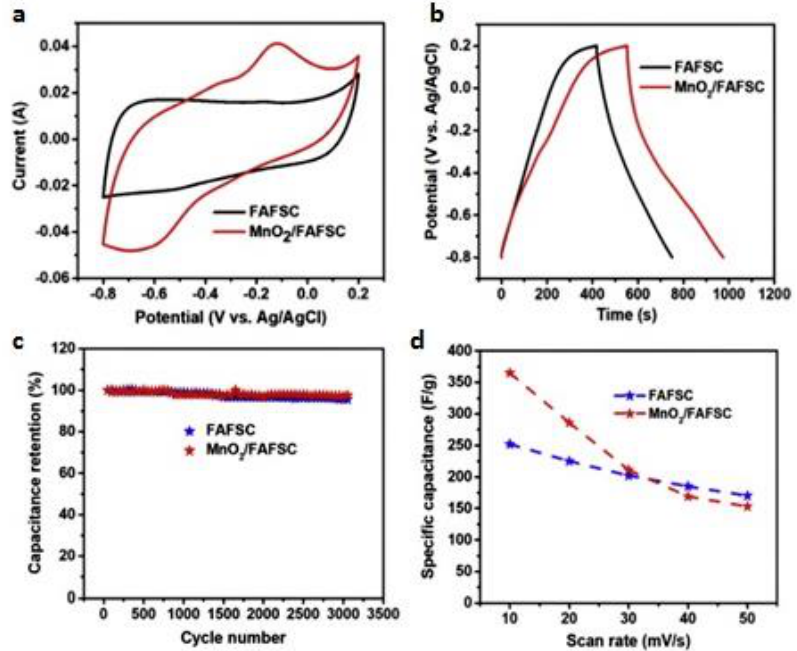
Figure 5. ( a ) FAFSC and MnO 2 /FAFCS CV curves at a constant scan rate of 10 mV s − 1 ; ( b ) GCD curves at a constant current density of 6 mA cm − 2 for the FAFSC and MnO 2 /FAFSC working electrodes; ( c ) the capacitance retention of the FAFSC and MnO 2 /FAFSC composite electrodes at a current density of 40 mA cm − 2 over 3000 cycles; ( d ) the specific capacitance of FAFSC and MnO 2 /FAFSC at different scan rates. This figure is reprinted from [105], with permission from Elsevier B.V.,